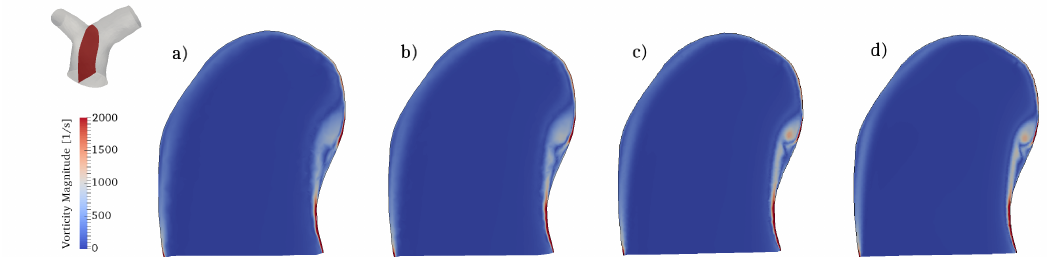
Figure 7. Mesh refinement study. Contour of the vorticity magnitude in a slice located along a longitudinal section of the MPA (see top left corner). Results for ( a ) coarse; ( b ) medium; ( c ) fine and ( d ) very fine